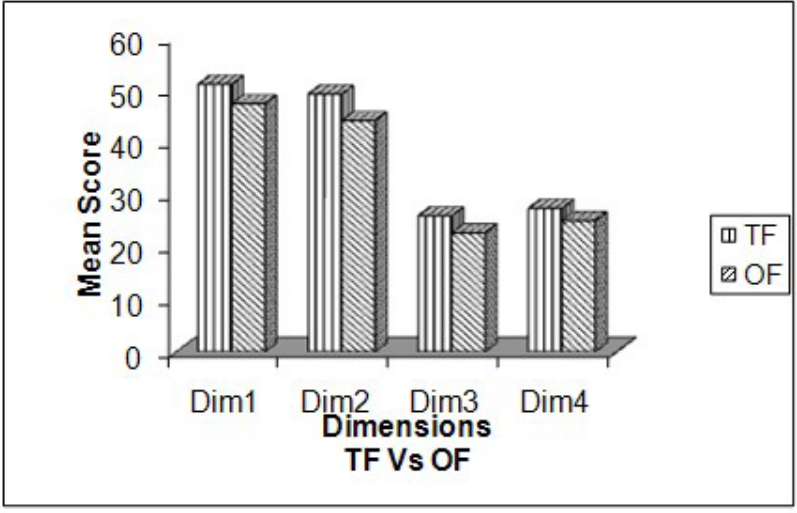
Figure 5 . Dimension-wise comparison of mean values for academic motivation of TES and OES female